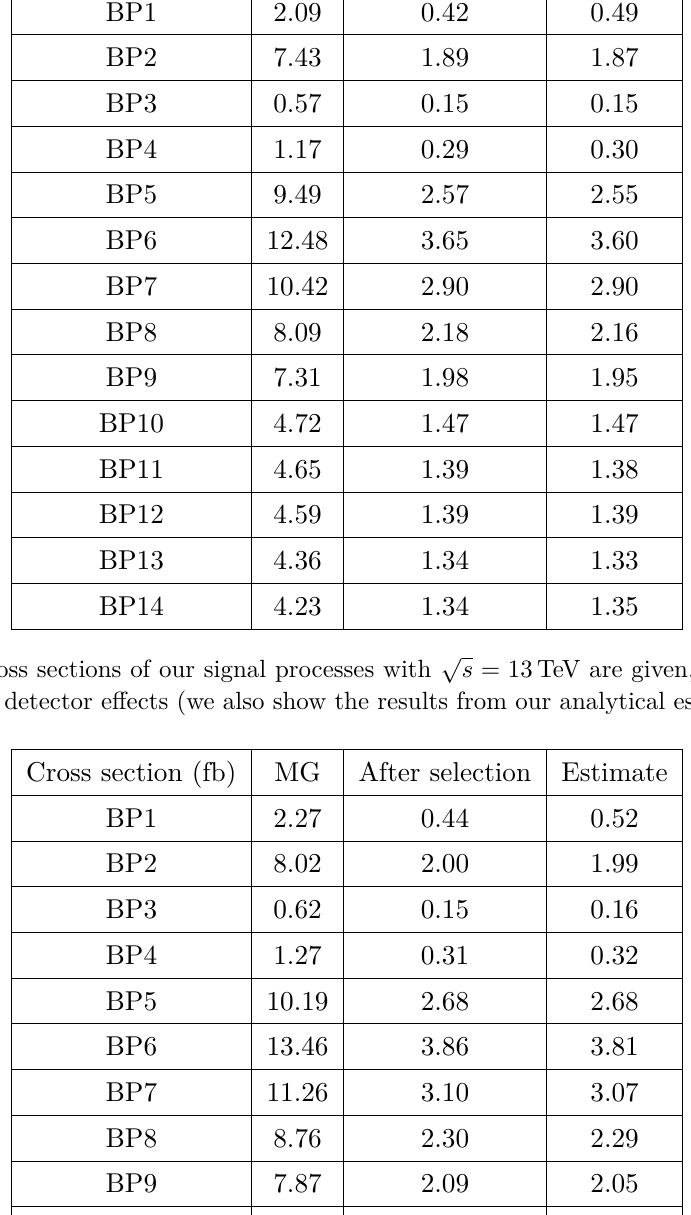
Table 6 . The cross sections of our signal processes with account cuts and detector effects (we also show the results from our analytical